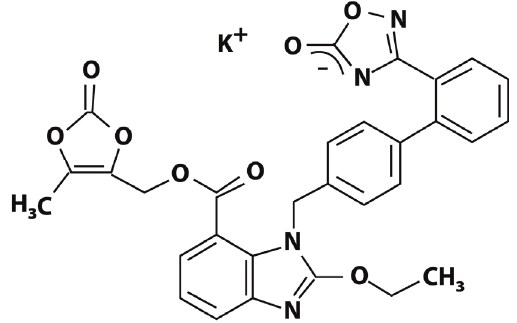
Fig. 1 . Chemical structure of